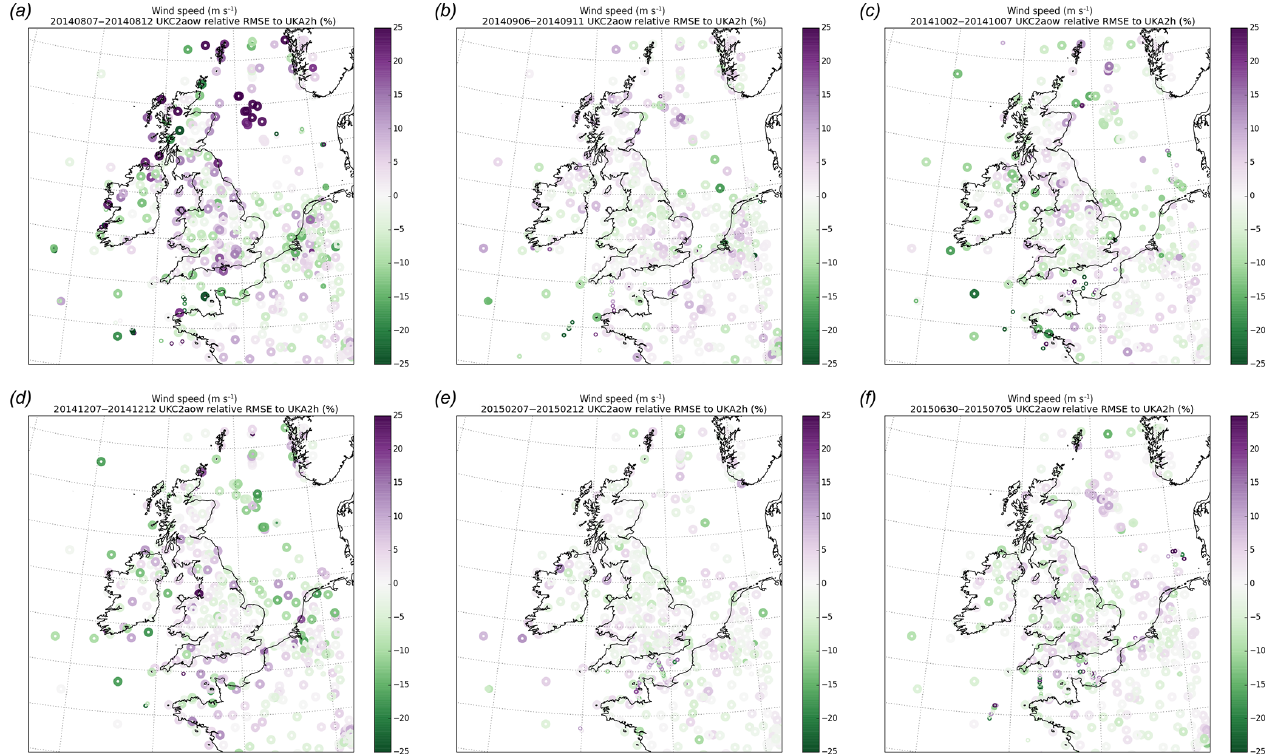
Figure 8. Differences in case study atmosphere model RMSE statistics for near-surface wind speed, comparing statistics computed for the fully coupled UKC2aow simulation as a % difference relative to the atmosphere-only UKA2h runs. Green sites indicate an overall reduction in RMSE relative to the control. Results are shown for 5-day case study periods in (a) August 2014, (b) September 2014, (c) October 2014, (d) December 2014, (e) February 2015 and (f) July 2015. RMSE statistics are computed by comparing UKC2aow and UKA2h model outputs with in situ observations. Note that only an inner section of the domain is presented for